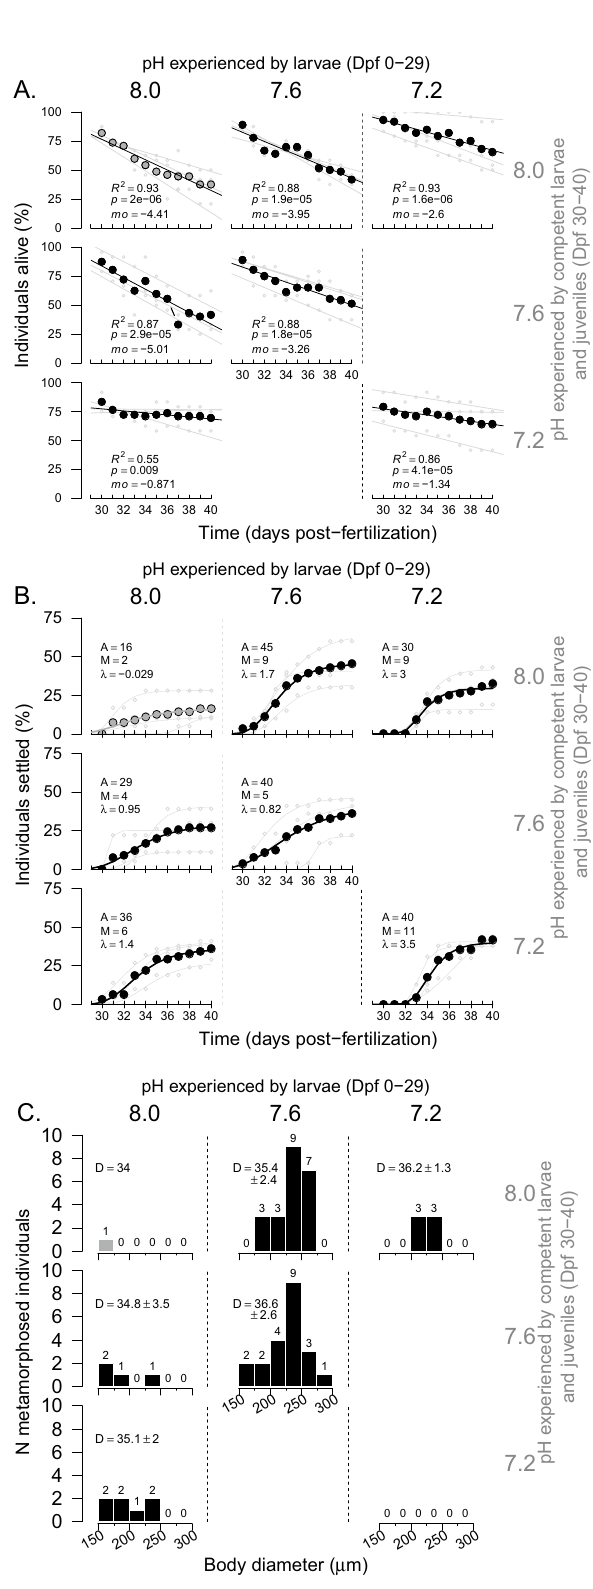
Figure 3. Effect of the combination of pH treatments on the settlement experiment (Dpf 29–40): At Dpf 29, individuals from three pH (“ pH experienced by larvae ”, vertical pHs) were distributed in one of three pH treatments (horizontal pHs, see Fig. 1B). Full data points represent proportions calculated on the three well-plates combined (n = 72), while light grey data points are calculated in each of the well-plates (n = 24). ( A ) Mortality rates ( mo , % indiv. day –1 ) were calculated as the linear relationship between survival (individuals alive, %) and days. ( B ) Settlement success (%) were fitted with Gompertz models (see Fig. 1B). A is the maximum cumulated settlement (% larvae), M is the maximum settlement rate (% larvae day –1 ) and λ is the initial latency period (days). Results of the models are detailed in Table 1. ( C ) Distribution of the newly metamorphosed individuals by body diameter at metamorphosis (μm). D represents the mean time (± SD) to metamorphosis